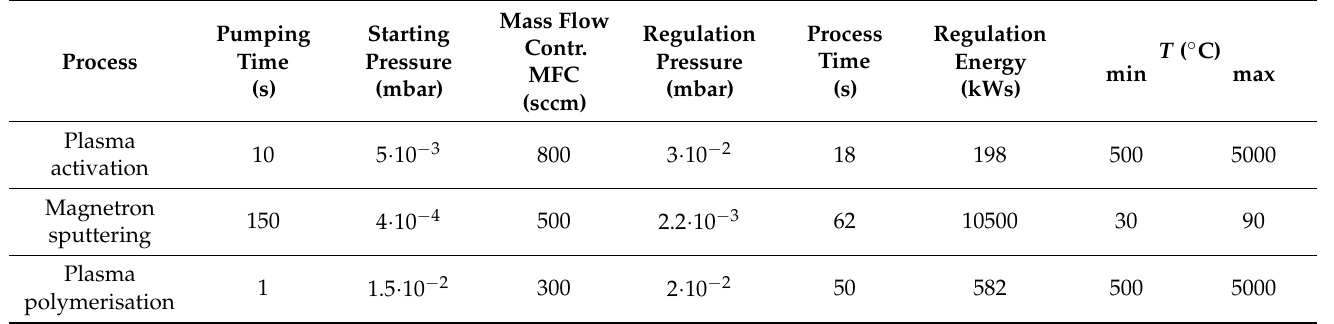
Table 2. Process parameters for one layer of aluminium PVD